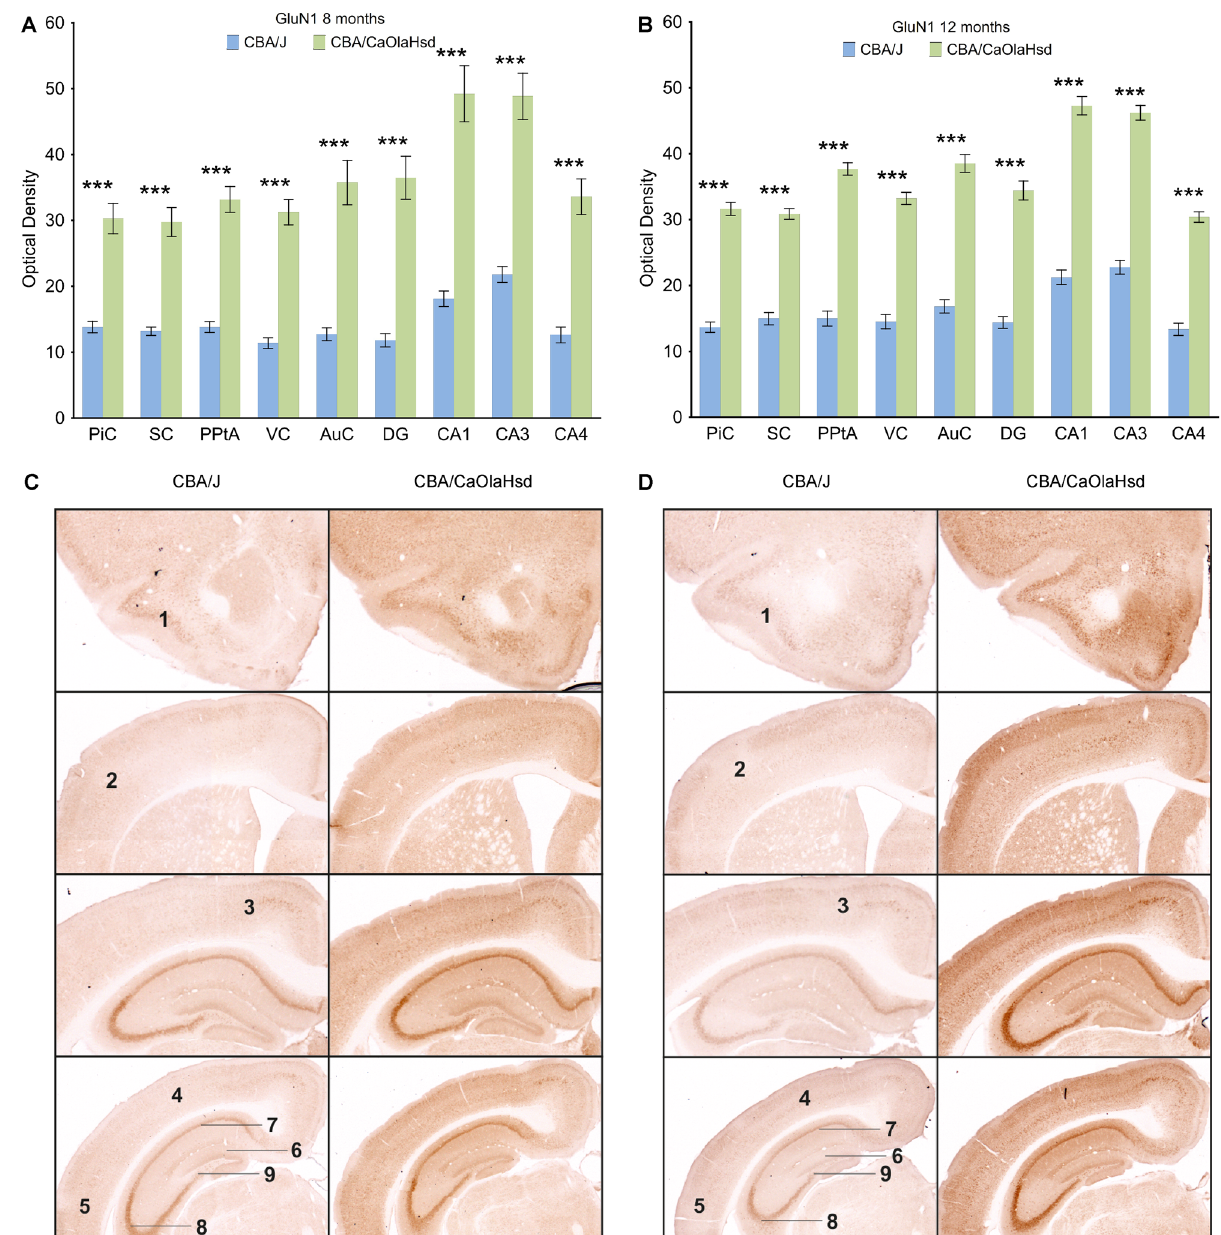
Figure 2. GluN1 expression is globally decreased in blind mice 8 months and 12 months postnatally. ( A , B ) Bar charts represent mean GluN1 subunit optical densities in different brain regions 8 and 12 months postnatally in CBA/J (blind) mice compared with CBA/CaOlaHsd mice. Subunit density is significantly decreased in the piriform cortex (PiC), somatosensory cortex (SC), posterior parietal cortex (PPtA), visual cortex (VC), auditory cortex (AuC), dentate gyrus (DG), CA1, CA3, and CA4 in CBA/J mice. *P < 0.05; **P < 0.01; ***P < 0.001. (C,D) DAB-stained coronary sections showing GluN1 expression in CBA/J and CBA/ CaOlaHsd mice 8 and 12 months postnatally. The photomicrographs highlight the changes as described in ( A and B ). 1: piriform cortex, 2: somatosensory cortex, 3: posterior parietal cortex, 4: visual cortex, 5: auditory cortex, 6: dentate gyrus, 7: CA1, 8: CA3, 9: Blind mice express markedly poorer LTP compared to mice that have no sensory deficit. Impairments are consistent across the lifespan of the animals. At an age of 3 months, CBA/ CaOlaHsd mice responded to HFS with long-term potentiation (LTP) that lasted for over 24 h (Fig. 6A). CBA/J mice responded to the same stimulation paradigm with LTP of smaller magnitude that was however not sta- tistically different compared to LTP in CBA/CaOlaHsd mice (ANOVA, F 1,11 = 1.74, p = 0.21; interaction effect : F 22 ,242 = 0.52, p = 0.97; n = 6 for CBA/J and n = 7 for CBA/CaOlaHsd; Fig. 6A).